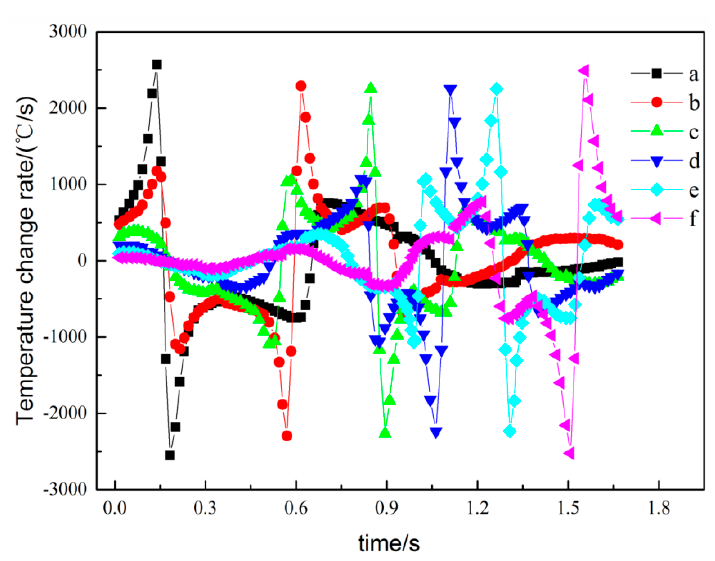
Figure 4. The temperature change rate curves of points a, b, c, d, e, and f.